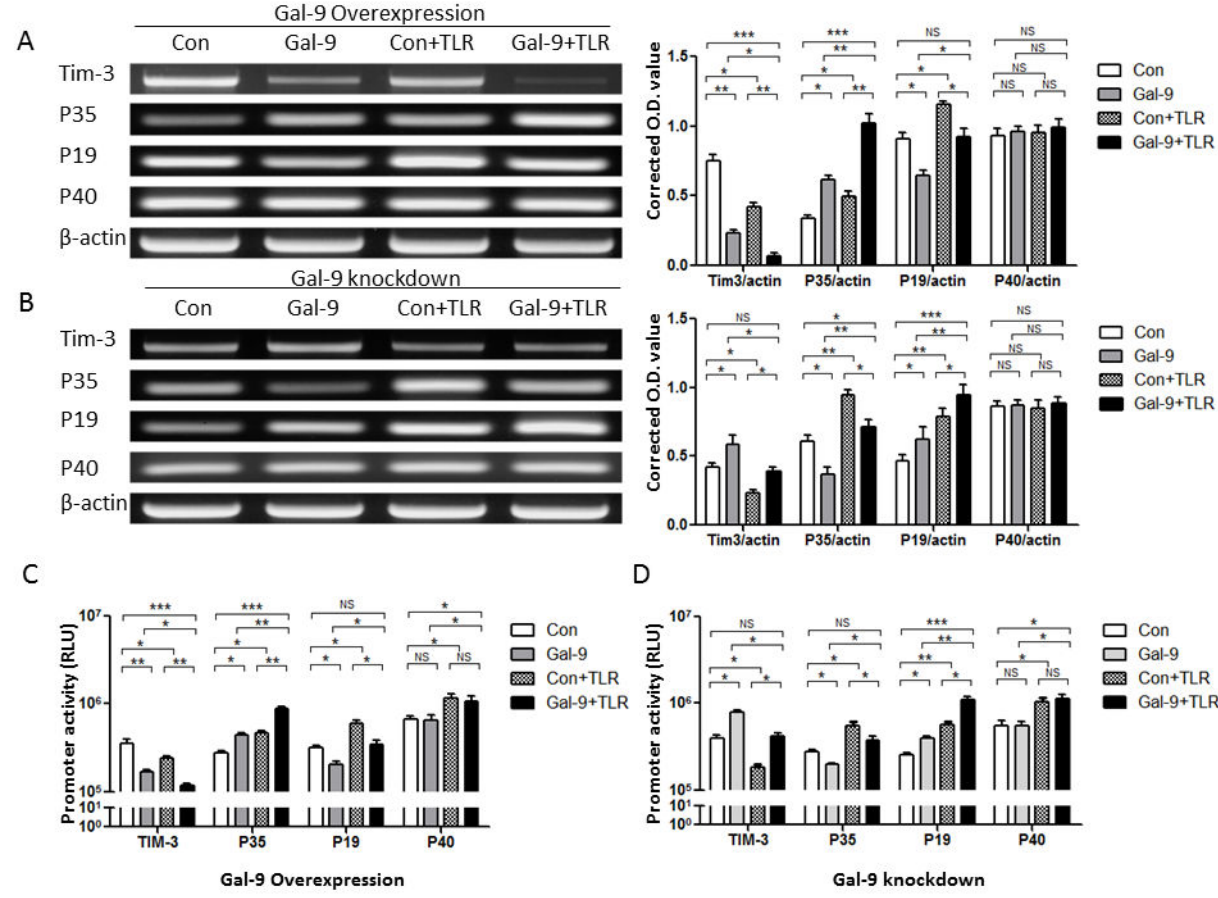
Figure 1. Tim-3 and IL-12/IL-23 mRNA expression in THP-1 cells with altered Gal-9 expressions with or without TLR stimulations. A) RT-PCR detection of Tim-3, IL-12p35, IL-23p19, and IL-12/IL-23p40 mRNAs in THP-1 cells transfected with Gal-9 plasmid in the absence or presence of TLR stimulations. THP-1 cells were transfected with either pBKCMV3-Gal-9 plasmid (Gal-9) or pBKCMV3 empty vector (Con) for 24 h, stimulated with or without LPS and R848 for 6 h, followed by RT-PCR measuring Tim-3, IL-12p35, IL-23p19, IL-12/IL-23p40 mRNA expressions. β-actin served as loading control to normalize target gene levels. Data are shown as representative imaging (left) and mean ± SE of corrected optimal densitometry (O.D) values from three independent experiments (right). *P<0.05, **P<0.01, ***P<0.001, NS = no significance, analyzed by multiple comparisons testing/least significant difference on the ANOVA Prism software. B) RT-PCR detection of Tim-3, IL-12p35, IL-23p19, and IL-12/IL-23p40 mRNAs in THP-1 cells transfected with Gal-9 siRNAs in the absence or presence of TLR stimulations. THP-1 cells were transfected with either Gal-9 or control siRNAs for 48 h, stimulated with or without LPS/R848 for 6 h, followed by RT-PCR measuring Tim-3, IL-12p35, IL-23p19, IL-12/IL-23p40 mRNA expressions. β-actin served as loading control. Data are shown as representative imaging (left) and mean ± SE of corrected optimal densitometry (O.D) values from three independent experiments (right). *P<0.05, **P<0.01, ***P<0.001, NS = no significance, analyzed by multiple comparisons testing/least significant difference on the ANOVA Prism software. C) Enhanced Gal-9 expression and TLR stimulation on Tim-3, IL-12, IL-23 promoter activities. pBKCMV3-Gal-9 or control vector was transiently transfected into THP-1 cells, along with either Tim-3, or IL-12p35, or IL-23p19, or IL-12/IL-23p40 promoter luciferase reporter vectors. 24 h after transfection, the cells were stimulated with or without LPS/R848 for 6 h, followed by luciferase assays for reporter gene transcriptional activities as described in Methods. Data are shown as mean ± SE of triplicate samples for relative luciferase units (RLU). *P<0.05, **P<0.01, ***P<0.001, NS = no significance, analyzed by multiple comparisons testing/least significant difference on the ANOVA Prism software. D) Silenced Gal-9 expression and TLR stimulation on Tim-3, IL-12, IL-23 promoter activities. Gal-9 or control siRNAs was transiently transfected into THP-1 cells, along with either Tim-3, or IL-12p35, or IL-23p19, or IL-12/IL-23p40 promoter reporter vectors. 48 h after transfections, the cells were stimulated with or without LPS/R848 for 6 h, followed by luciferase assays. Data are shown as mean ± SE of triplicate samples for relative luciferase units (RLU). *P<0.05, **P<0.01, ***P<0.001, NS = no significance, analyzed by multiple comparisons testing/least significant difference on the ANOVA Prism software. doi: 10.1371/journal.pone.0072488.g001 PLOS ONE |